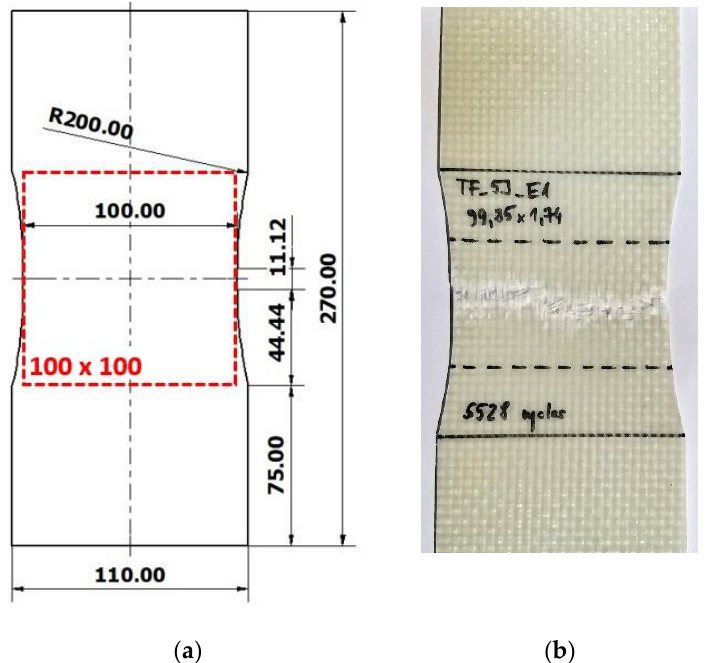
Figure 1. ( a ) Fatigue aging specimen with the shape adapted for the low velocity impact test; ( b ) damage localization in GFRE [0°/90°] 4 specimen subjected to 5.5 × 10 3 low cyclic fatigue (LCF) loading.